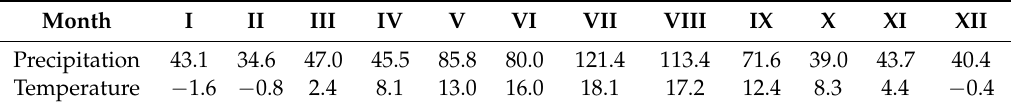
Table 2. Mean monthly precipitation (mm) and air temperatures ( ◦ C)—multi-annual data